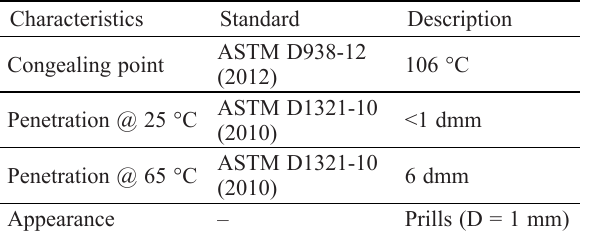
resultsUnitStandard testTest